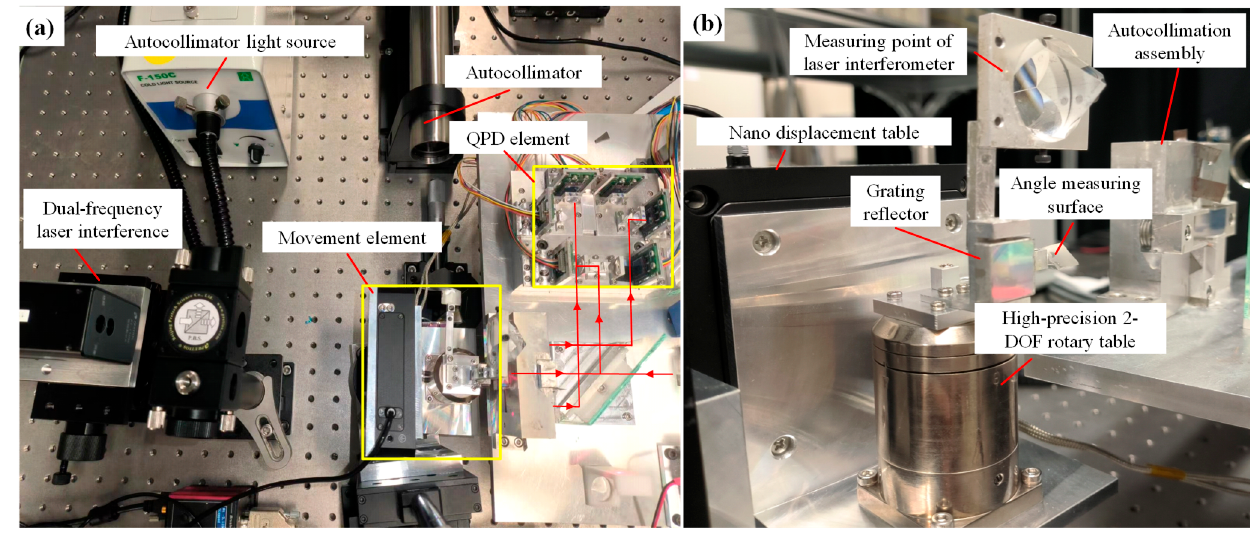
Figure 4. ( a ) The test bench; ( b ) movement